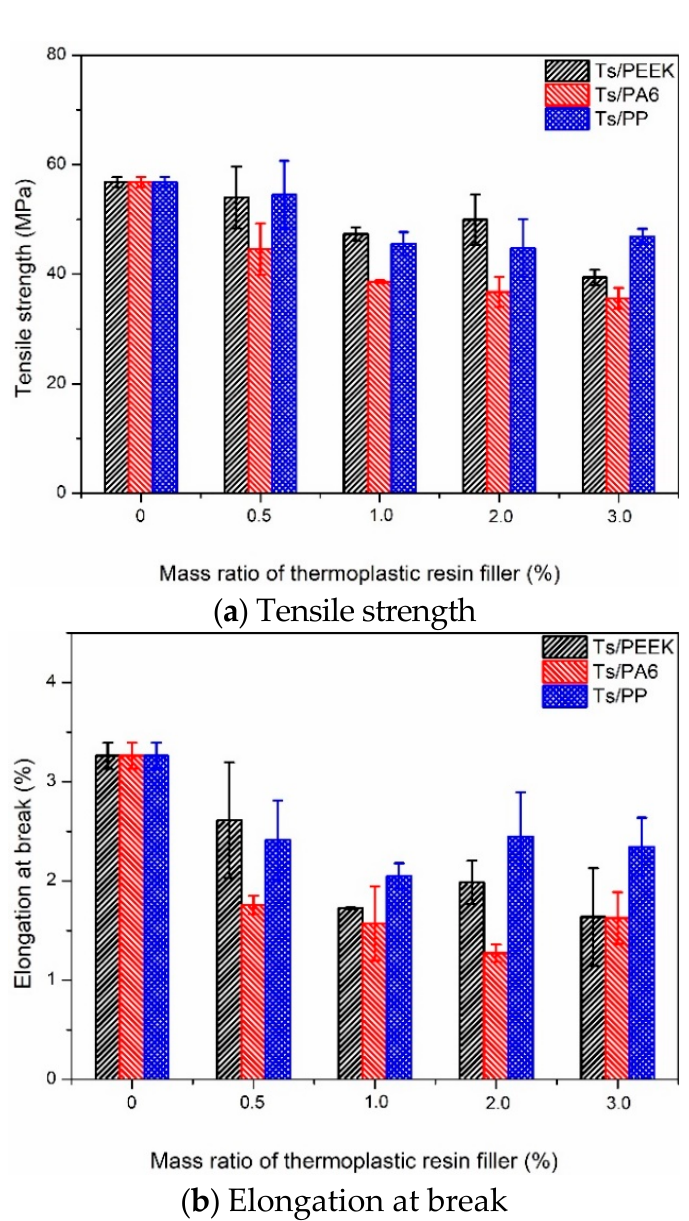
Figure 2. Effects of thermoplastic resin fillers on the tensile properties of Ts resin of ( a ) tensile strength and ( b ) elongation at break.